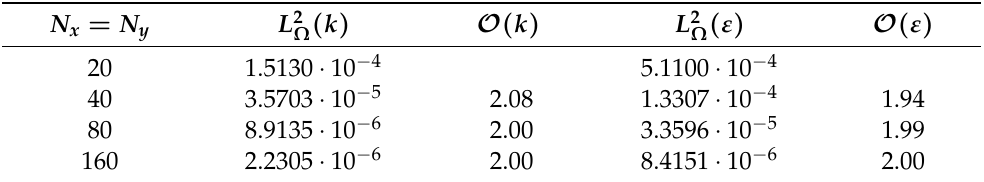
Table 2. Spatial L 2 error norms and convergence rates for the MMS test obtained at time t = 1 using the hybrid FV/FE method for Cartesian grids.